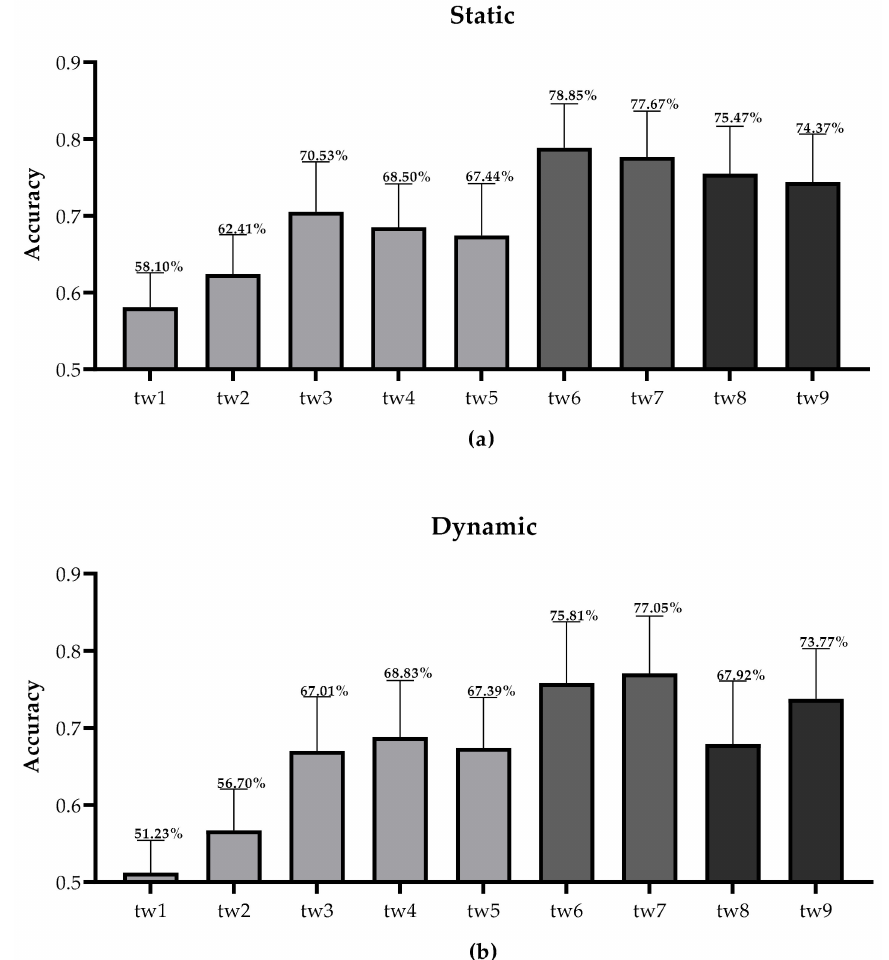
Figure 7. The classification accuracies of di ff erent time windows (tw1–9) under two visual stimuli. ( a ) Static visual stimulation. ( b ) Dynamic visual